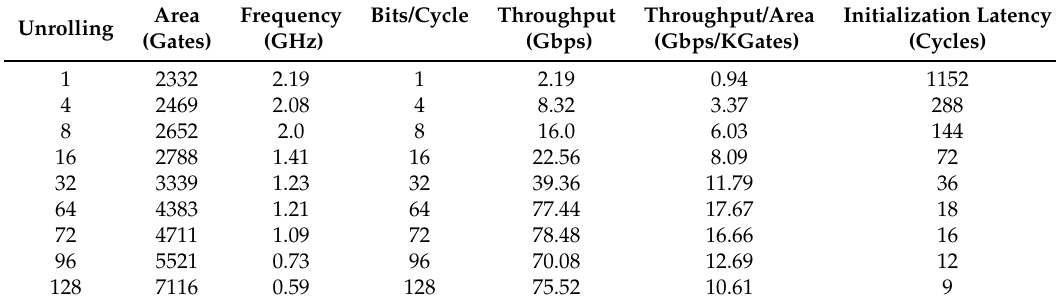
Table 11. Trivium synthesis results (130 nm).